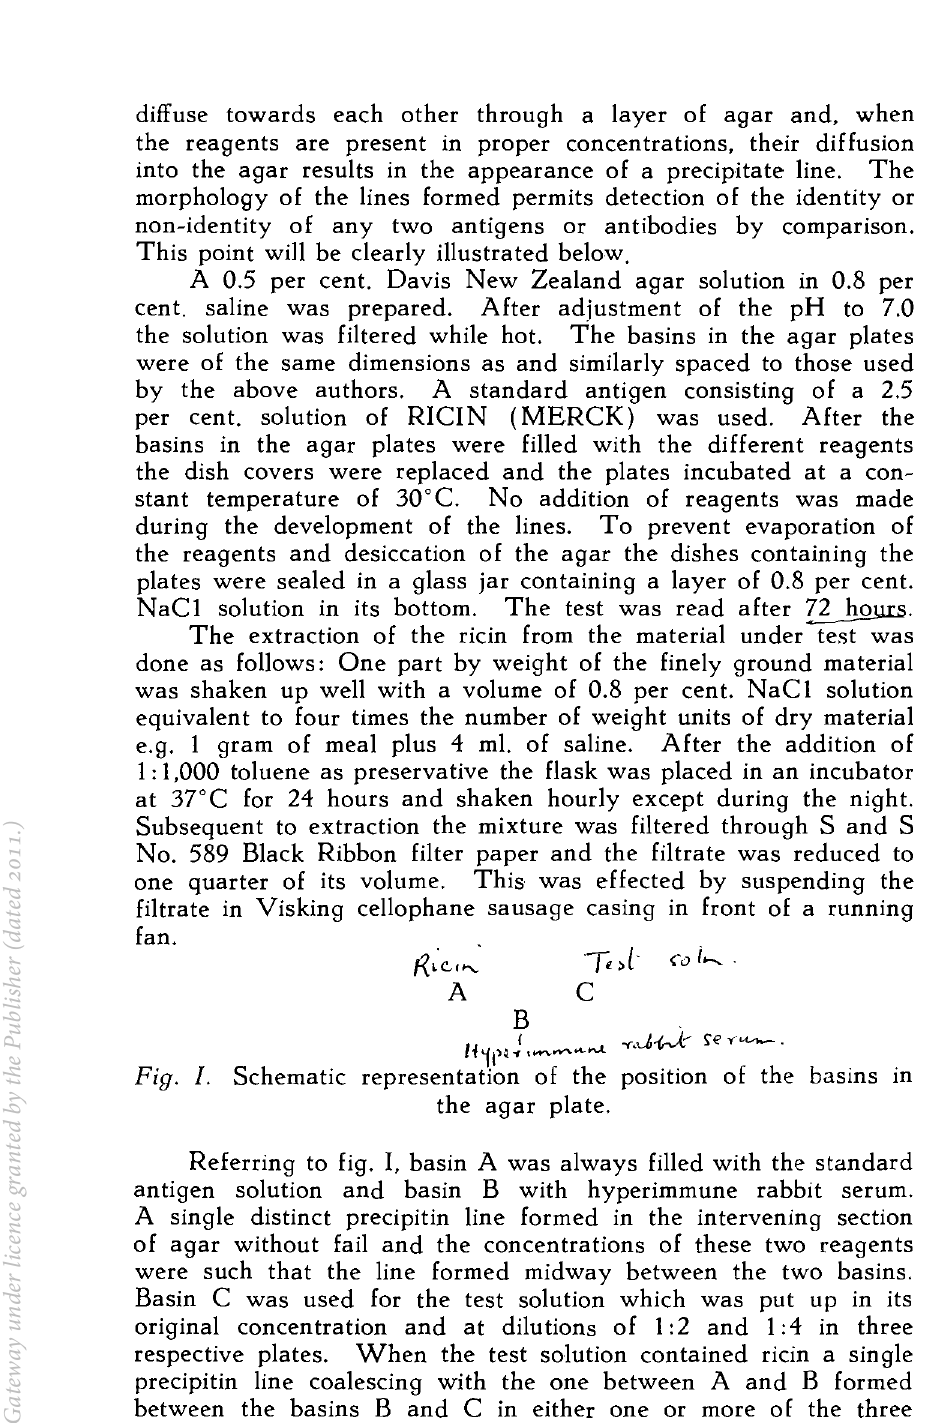
B { ..,-".J,-("..k <;e '""'-'>- " I ~it')~'" t"--''''''''''''-io''\.A. representation of the position of the basins in the agar